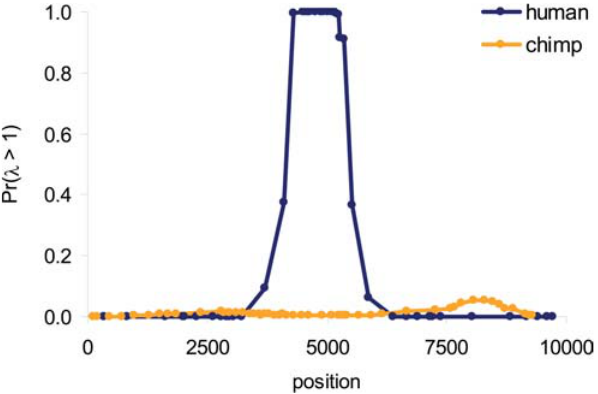
Figure 3. Estimates of Recombination Rate Variation in Humans and Western Chimpanzees In this model, there is at most one hotspot in the region, the location and width of which are unknown and estimated along with k and q . On the y -axis is an estimate of the posterior probability of elevated recombination, Pr( k . 1), between each pair of consecutive SNPs (plotted at the midpoint position). DOI: 10.1371/journal.pbio.0020155.g003